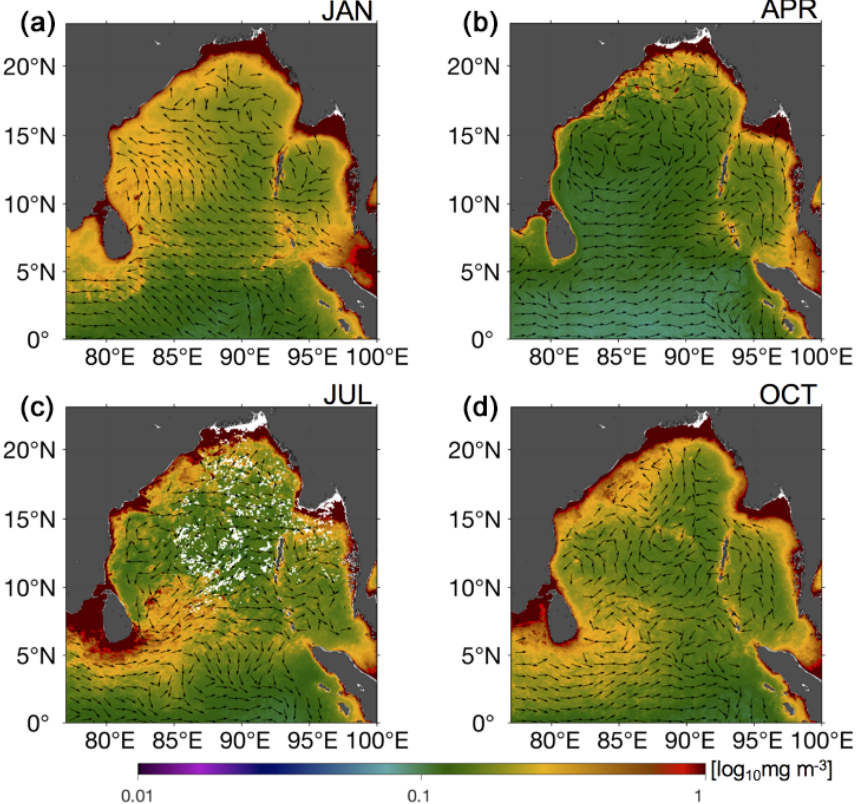
Figure 15. Climatology (2002–2018) of chlorophyll a concentrations (colour map) and current velocities (arrows) in the Bay of Bengal for (a) January, (b) April, (c) July, and (d) October. Chlorophyll climatology was obtained from the MODIS-Aqua product, and current velocities were obtained from the third-degree Ocean Surface Current Analysis Real-time (OSCAR)